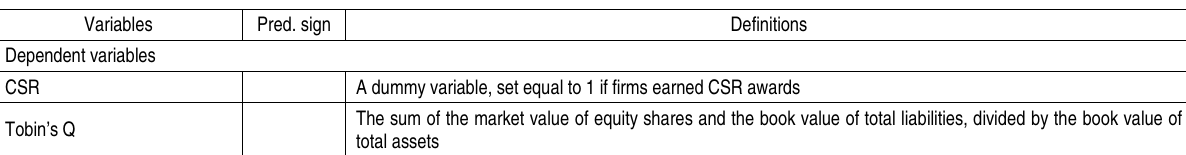
Table 2. Variable